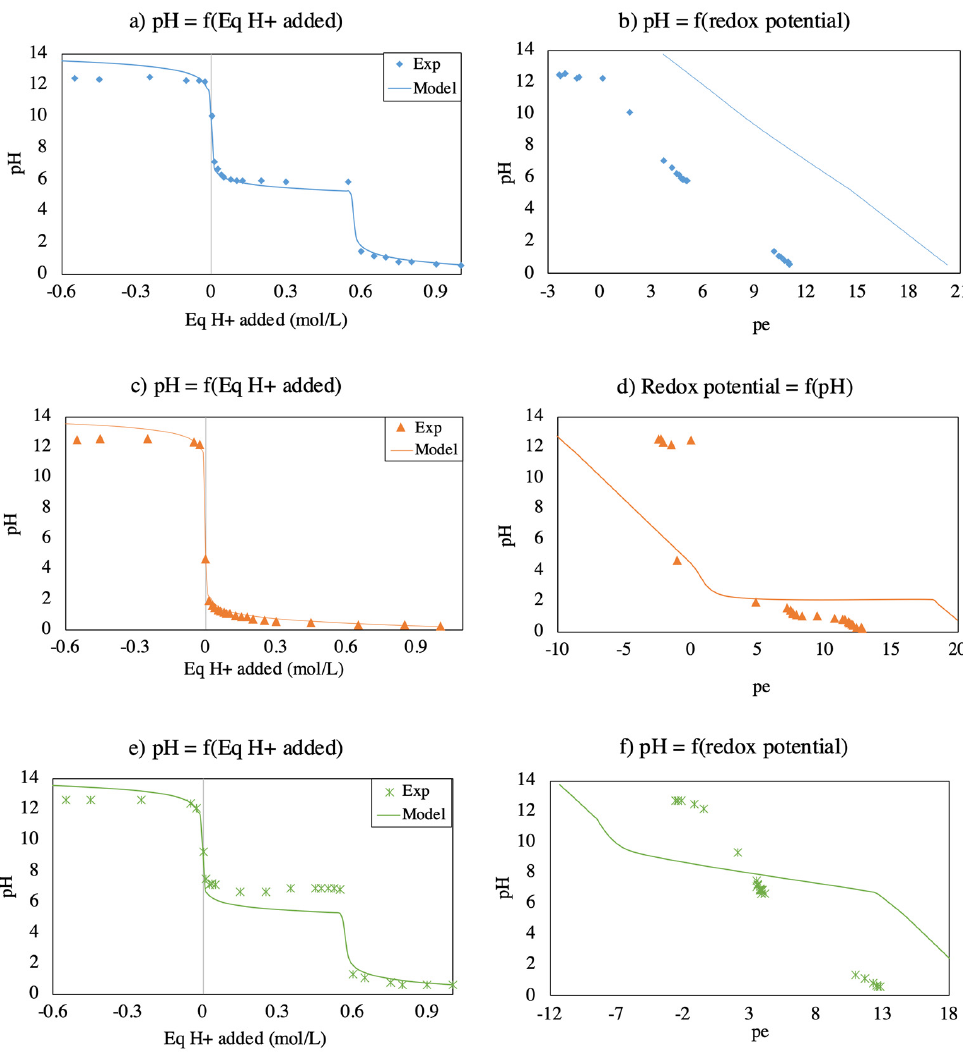
Figure 2. pH as a function of H + equivalents added for ( a ) calcite/SiO 2 , ( c ) pyrite/SiO 2 , and ( e ) calcite/pyrite/SiO 2 assemblages, and relationship between redox potential (pe) and pH for ( b ) calcite/SiO 2 , ( d ) pyrite/SiO 2 , and ( f ) calcite/pyrite/SiO 2 . The vertical line in ( b ) indicates the point of equilibrium with pure water.